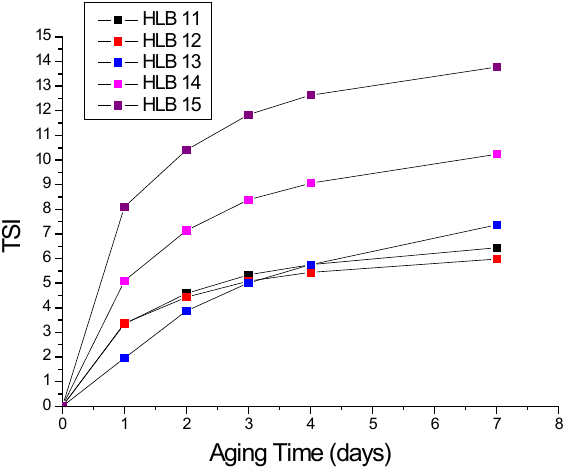
Figure 5. Variation of TSI with aging time as a function of HLB number for emulsions formulated with lemon essential oil.